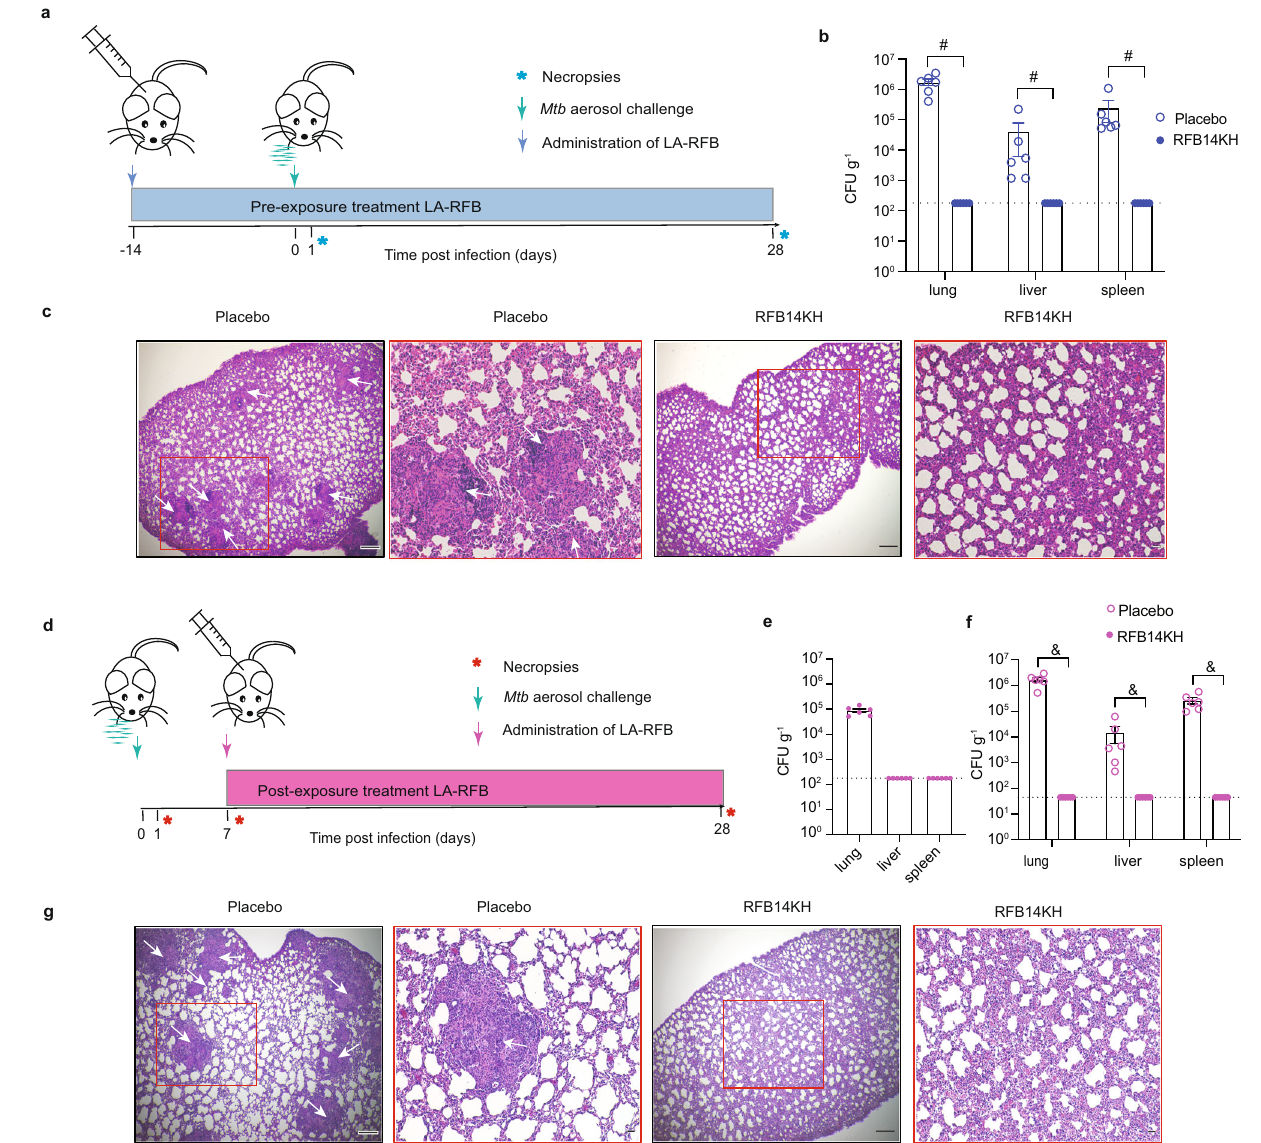
Fig. 6 | In vivo analysis of the ef fi cacy of RFB14KH against Mycobacterium tuberculosis infection.a Experimentalschemaforpre-exposuretreatmentef fi cacy testing of LA-RFB. BALB/c mice were untreated ( n =4) or treated with a single subcutaneous injection of placebo ( n =6) or RFB14KH ( n =6) formulations. Two weeks after treatment, mice were exposed to Mtb . Control untreated mice were used to determine the dose of exposure 24h after infection ( n =4). ISFI treated micewereanalyzed for Mtb infection 4weekspost-exposure. b Bacterialburdenin lung, liver, and spleen of placebo ( n =6)and RFB14KH ( n =6)treated mice4 weeks after Mtb exposure, mean +/ − SEM are shown ( # P =0.0022 Mann – Whitney U test). c H&E staining of lung sections shows pathological changes in mice treated with placebo but not in mice treated with RFB14KH. Representative sections from 6 placebo and 6 RFB14KH treated mice are shown d Experimental schema for post- exposureLA-RFBtreatment.BALB/cmice( n =22)wereexposedto Mtb ;24hlater,a group of 4 was analyzed to determine the exposure dose. Mtb infection was